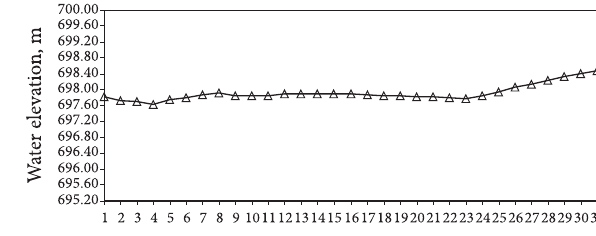
Fig. 11. Variation between reservoir water elevation and days in Goksu dam (March 2004)